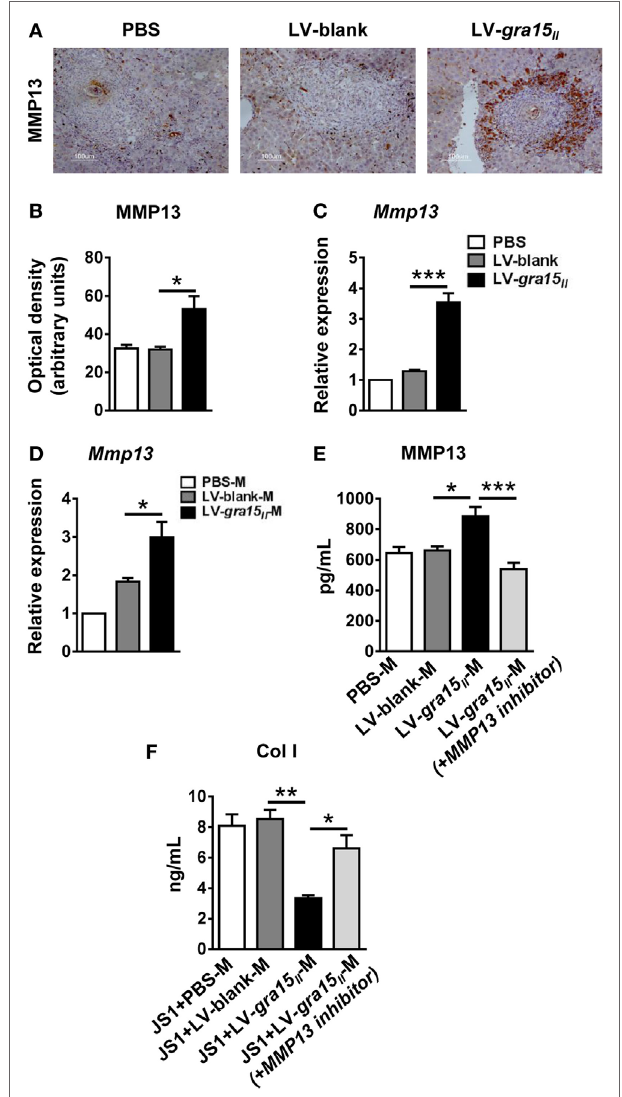
FigUre 6 | Matrix metalloproteinase 13 (MMP13) secreted from lentiviral vector- gra15 II -M was an important factor which degraded Col I. The protein level of MMP13 in liver was evaluated by IHC with quantitative analysis of optical density (a,B) . Liver RNA was extracted and the expression of MMP13 was analyzed by quantitative real-time PCR (qRT-PCR) (c) . The liver macrophage RNA was extracted and the expression of MMP13 was analyzed by qRT-PCR (D) . Liver macrophages culture supernatants with or without MMP13 inhibitor were collected and assayed for the secretion of MMP13 by enzyme-linked immunosorbent assay (ELISA) (e) . Liver macrophages and JS1 cells supernatants in co-culture system with or without MMP13 inhibitor were collected and assayed for the secretion of Col Ι by ELISA (F) . Data represent mean ± SD from multi-group experiments. * p < 0.05, ** p < 0.01, and *** p < 0.001 ( n = 4 each